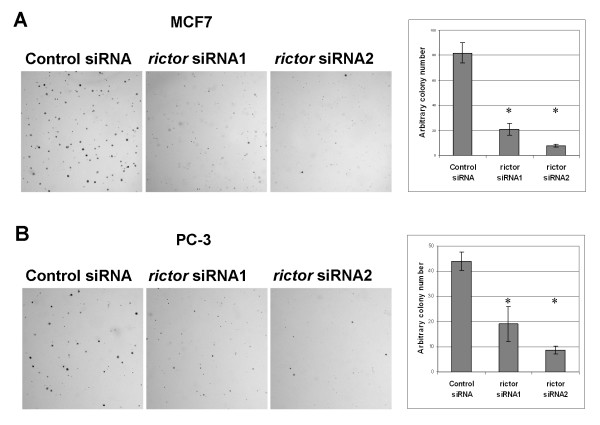
Inhibition of anchorage independent growth upon Rictor depletion. (A) MCF7 and PC3 cells were transfected with the siRNAs. Two days after transfection cells were detached with trypsin and seeded into soft agar. Colonies were allowed to grow for three weeks after which they were stained with crystal violet. (B) The number of visible colonies in a defined area was counted in three replicate samples. * Student's t-test p < 0.01.